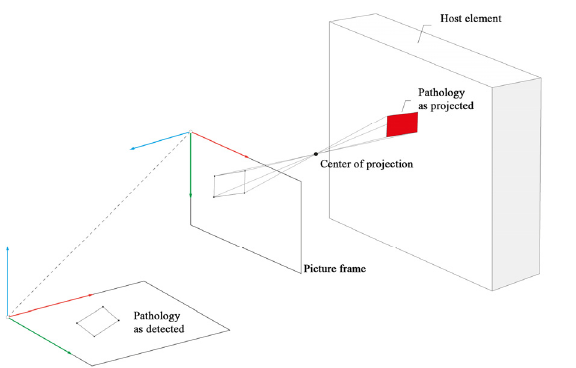
Figure 9. Projection of curves from analyzed images to BIM